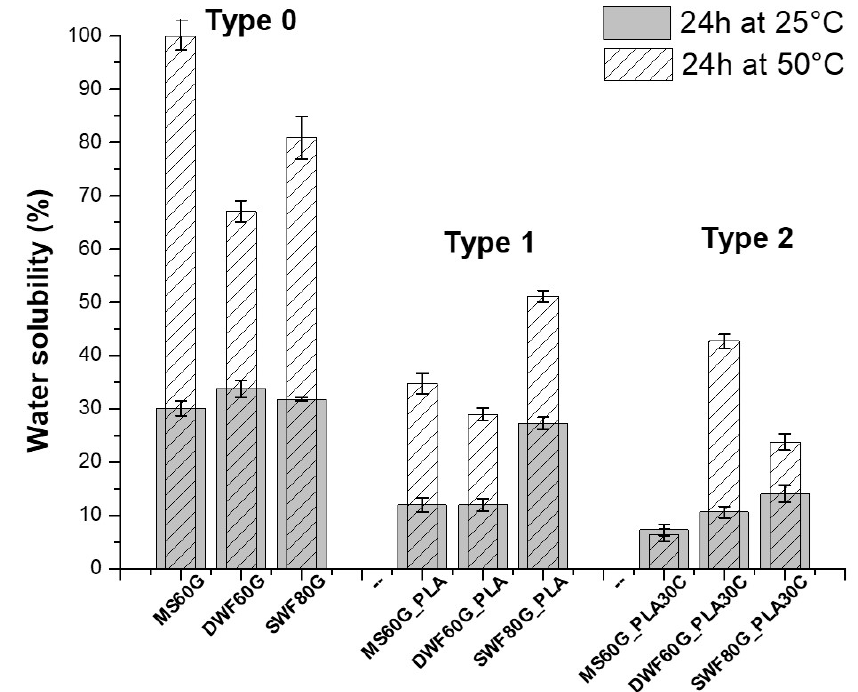
Figure 5. Water solubility at 25 and 50 °C for 24 h of maize starch (MS)-based, durum waste flour (DWF)-based and soft waste flour (SWF)-based bio-films.